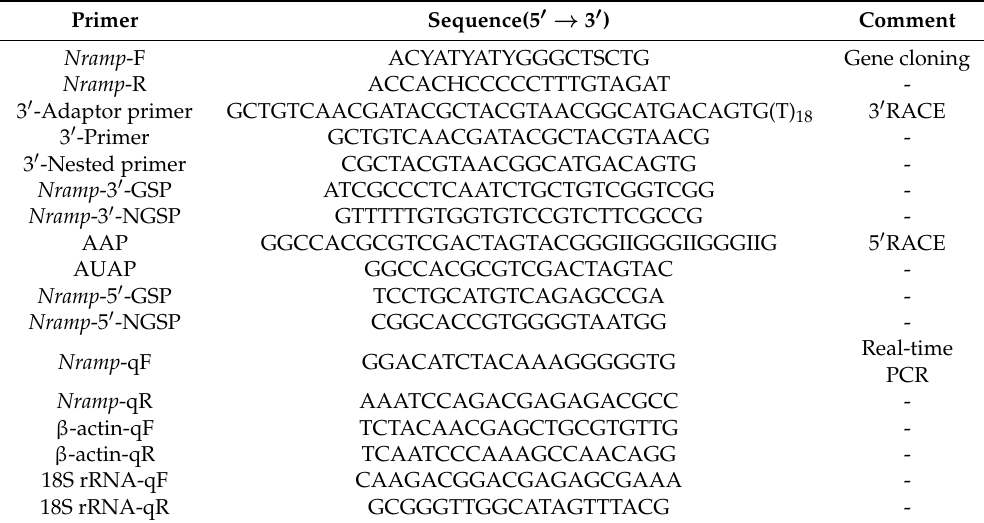
Table 1. Sequences of primers used in this